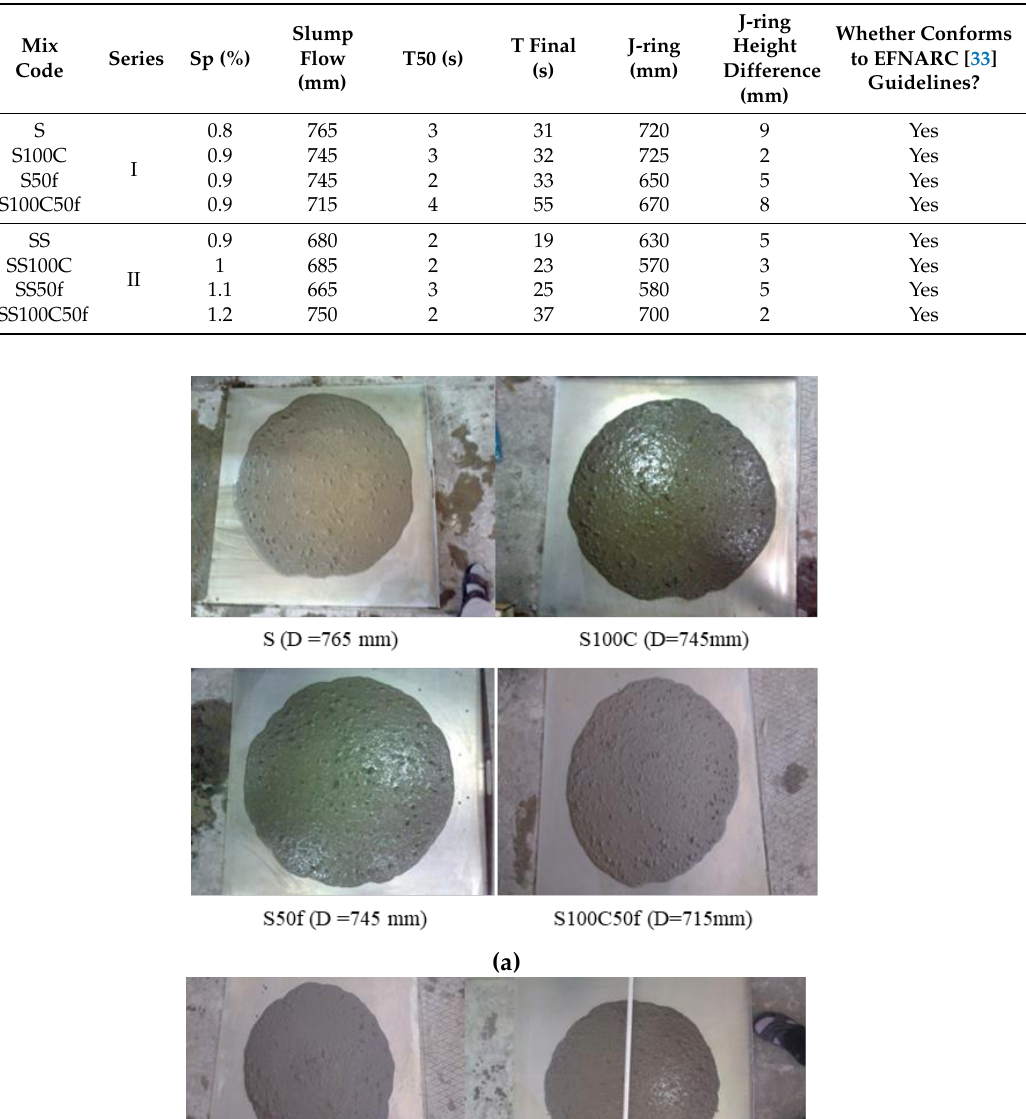
Table 3. Fresh properties test results.